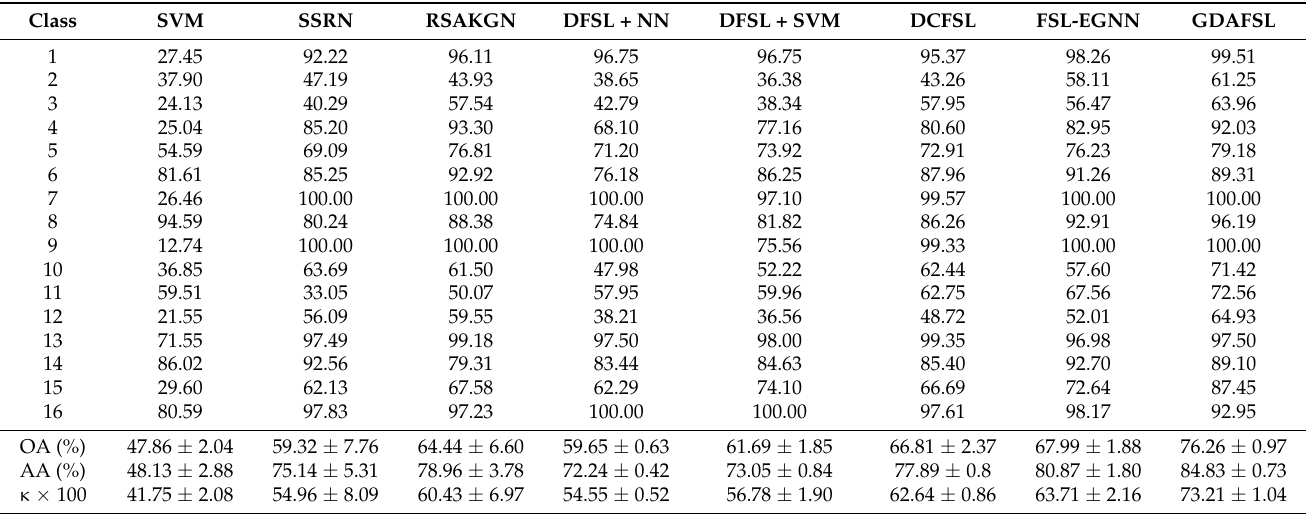
Table 7. Classification Results (%) of Various HSI Classification Methods on IP Dataset with 5 Labeled Samples Per Class.